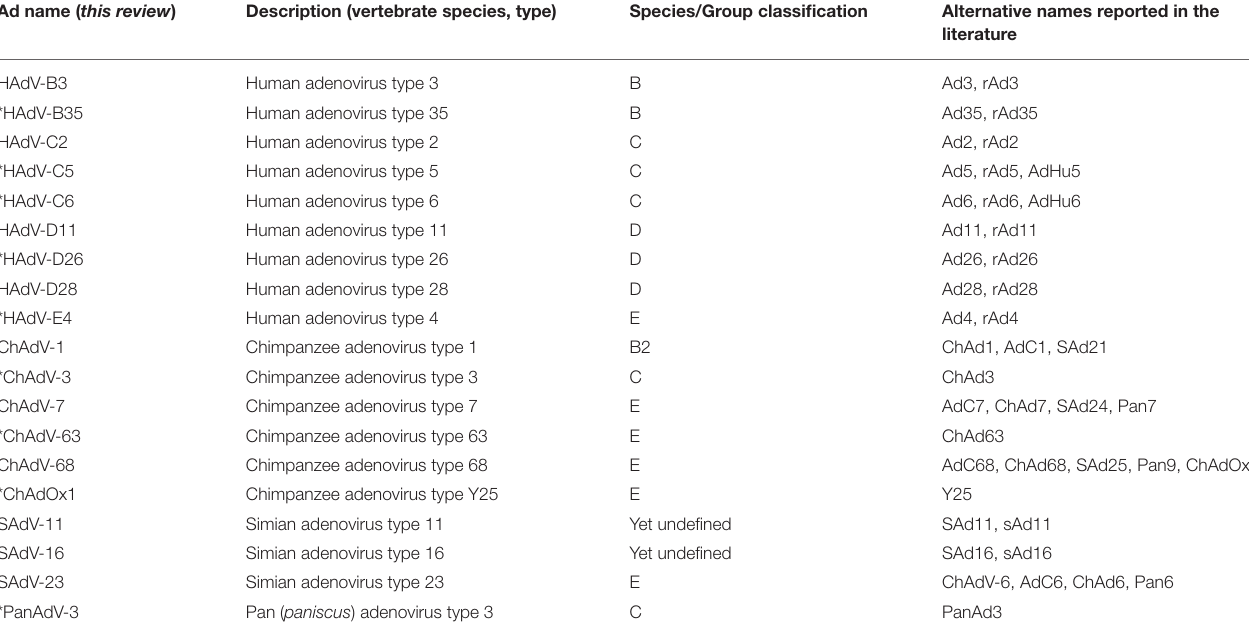
TABLE 1 | Nomenclature of adenoviruses discussed in this